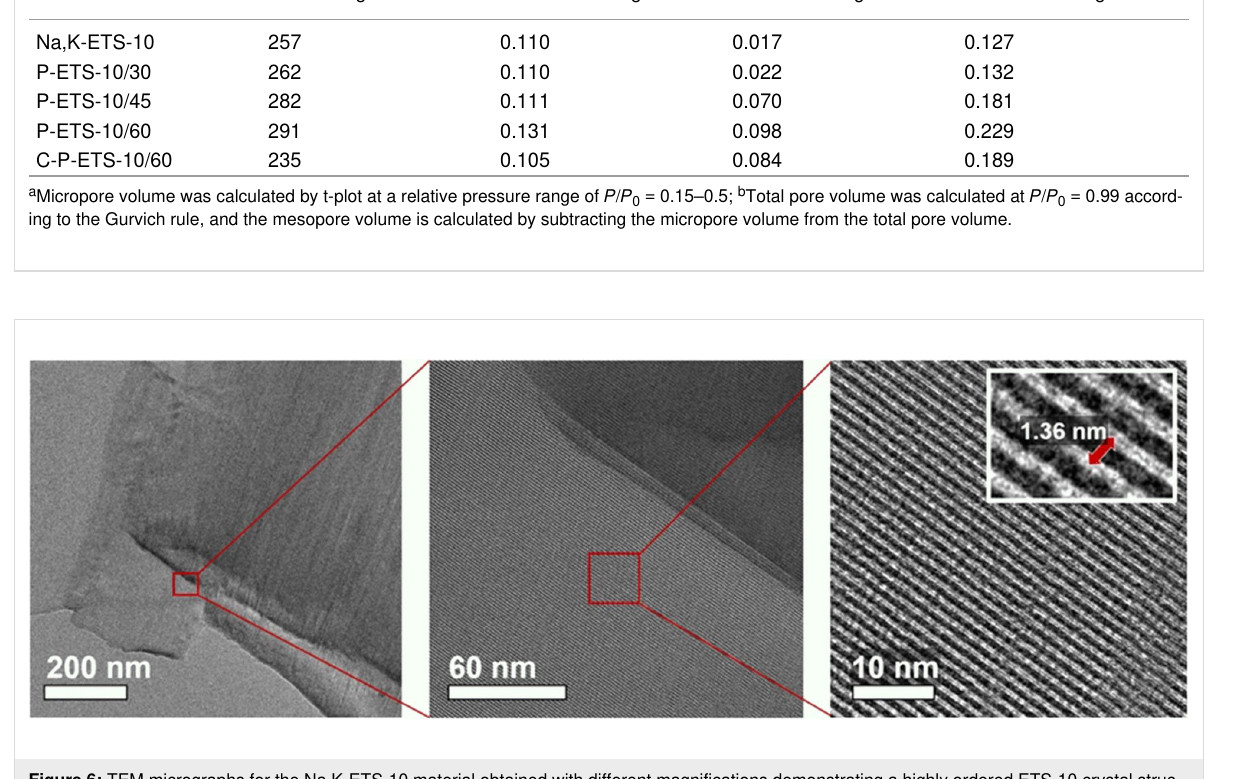
showing no visible defects on the length scale of hundreds of nanometers. The spacing between adjacent nanowires showed good agreement with literature data of 1.36 nm